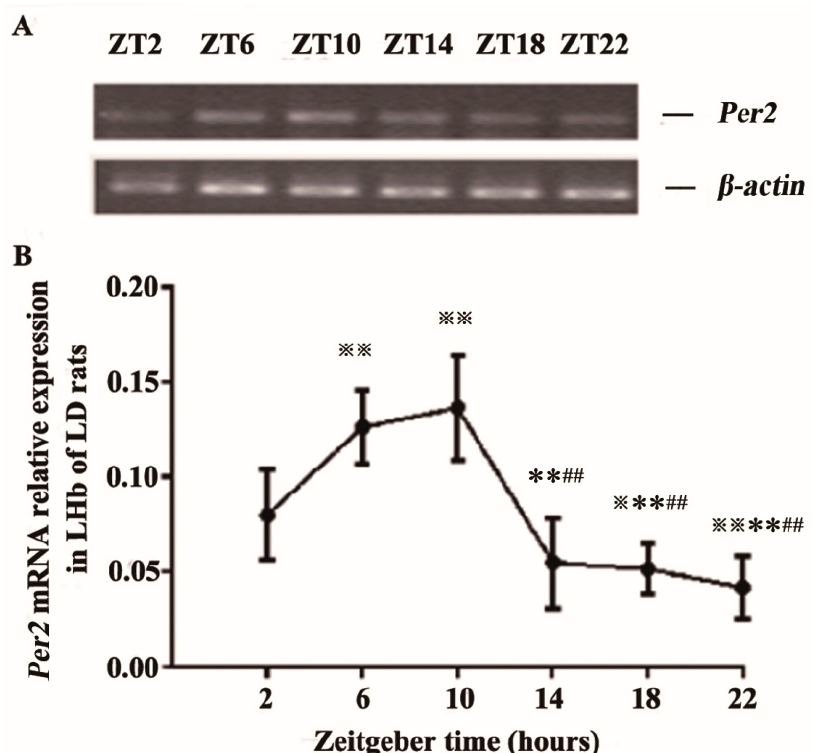
Figure 1. Rhythmic expression of Per2 mRNA in the lateral habenular nucleus (LHb) of LD rats. ( A ) Representative gel electrophoresis of real-time polymerase chain reaction products stained with ethidium bromide (EB), showing Per2 and β -actin mRNA in the LHb at six ZT time points; and ( B ) Relative quantitative analysis of Per2 mRNA in the LHb at six ZT time points. All values are normalized against the housekeeping gene β -actin . Data are presented as mean ± SD ( n = 6). ※ p < 0.05 and ※※ p < 0.01 compared with ZT2 time point; ** p < 0.01, compared with ZT6 time point; ## p < 0.01, compared with ZT10 time